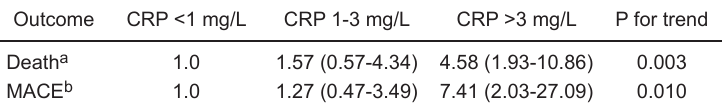
Table 2. Hazard ratio, odds ratio and 95% confidence intervals for MACE and deaths for the three CRP groups, adjusted for TIMI risk score and systolic blood